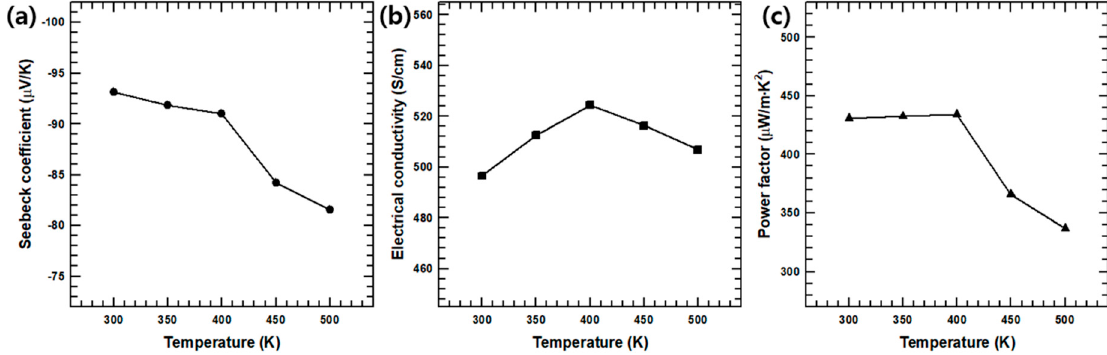
Figure 4. The temperature-dependent thermoelectric properties of the PEDOT:PSS-coated Ag 2 Se NWs: ( a ) Seebeck coefficient, ( b ) electrical conductivity, ( c ) power factor.